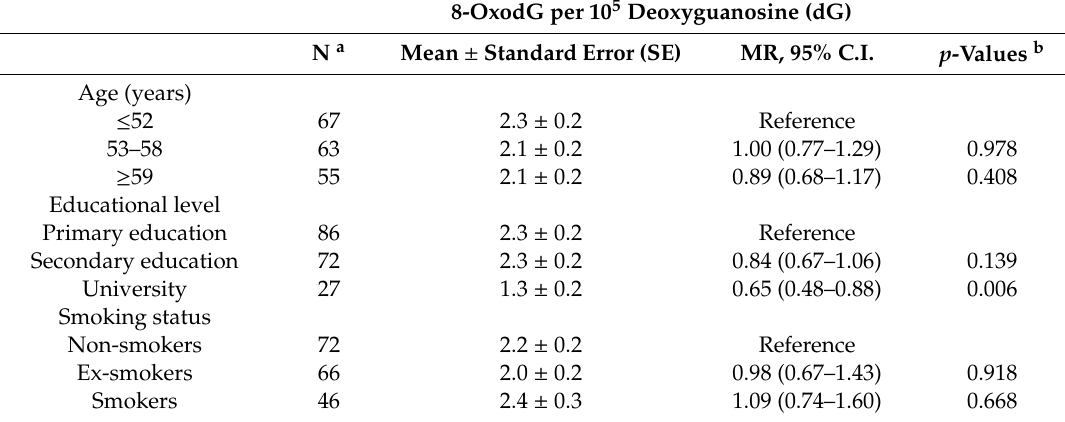
Figure 2. Panel of representative chromatographic patterns of 8-hydroxy-2 ′ -deoxyguanosine (8-oxodG) spots in five current ( A – E ) and five former exposed asbestos workers ( F – J ), and five unexposed healthy controls ( K – O ). Table 1. Average frequency of 8-hydroxy-2 ′ -deoxyguanosine (8-oxodG) in study population by age, educational level and smoking habits. Adjusted estimated of risk are expressed as Mean Ratio (MR) with their respective 95% confidence interval (95% CI).